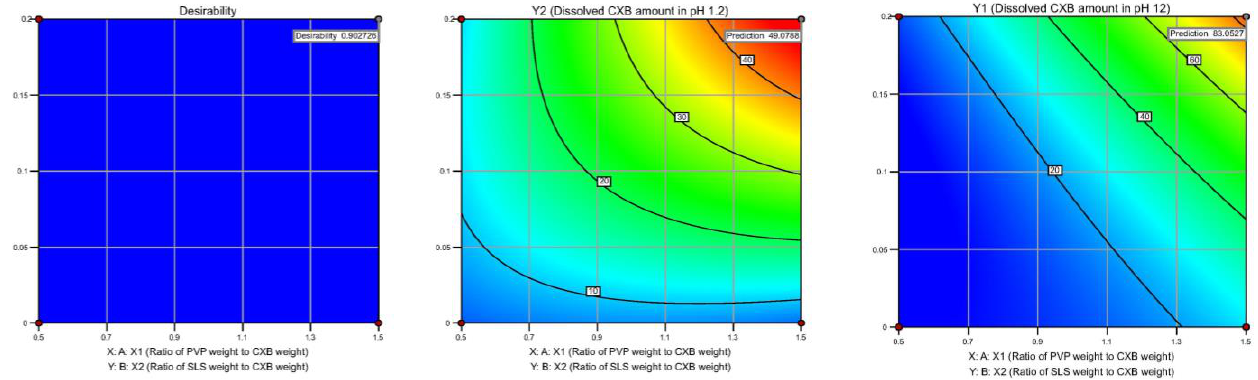
Figure 3. Contour plot of model validation.